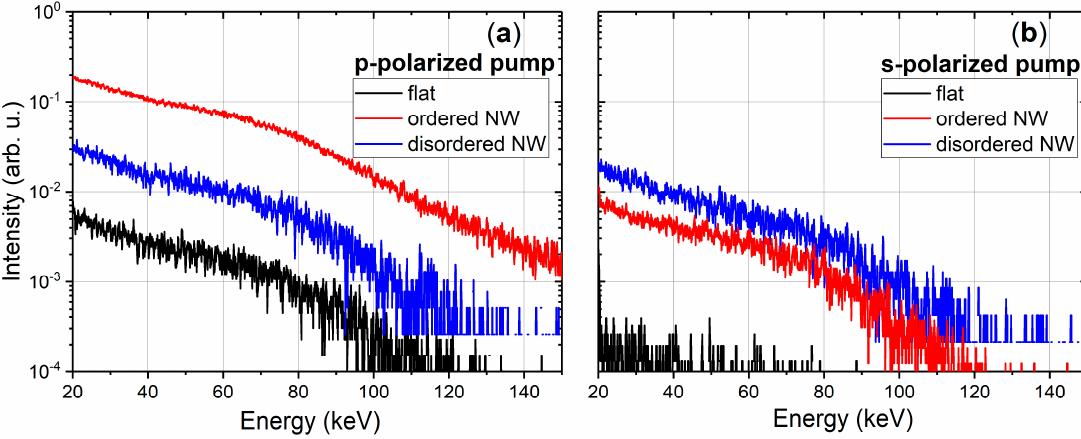
Figure 7. The background signal from the flat (black line) and nanostructured (ordered NW (red line), disordered NW (blue line)) ZnO targets for p-polarization ( a ) and s-polarization ( b ) detected by the CCD camera (CCD1).